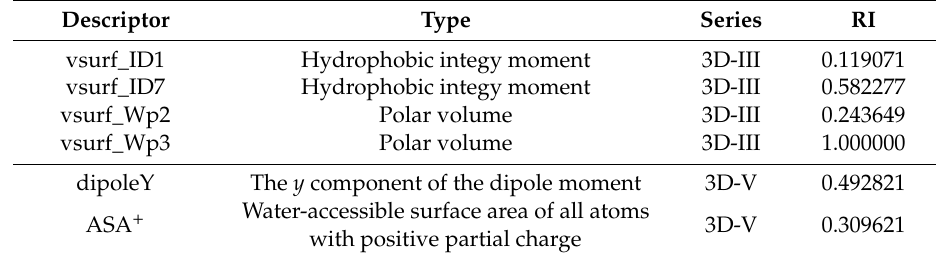
Table 3. Selected three-dimensional (3D) Surface Area, Volume and Shape Descriptors and Conformation-Dependent Charge Descriptors and the related relative importance (RI) values based on the developed QSAR